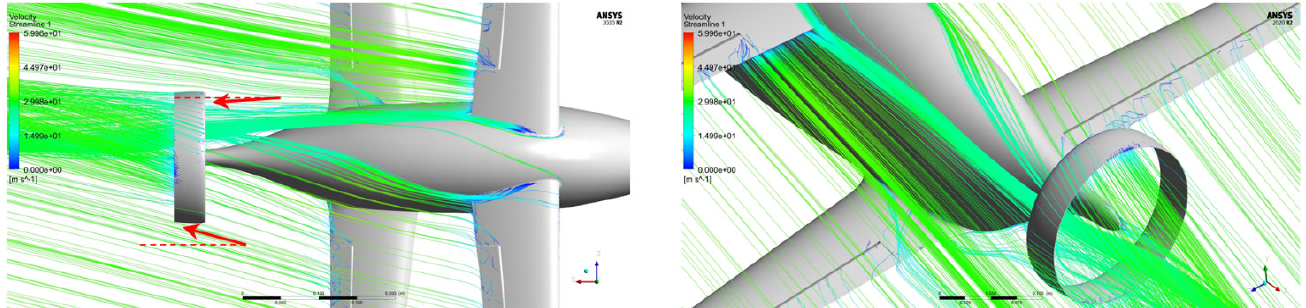
Figure 23. Velocity streamlines at a high sideslip β ~ 15° revealing the impact of the fuselage sidewash on the tail duct inner (shaded) side local effective angle of attack. Table 7. Pressure field of the tail duct in a horizontal section plane.